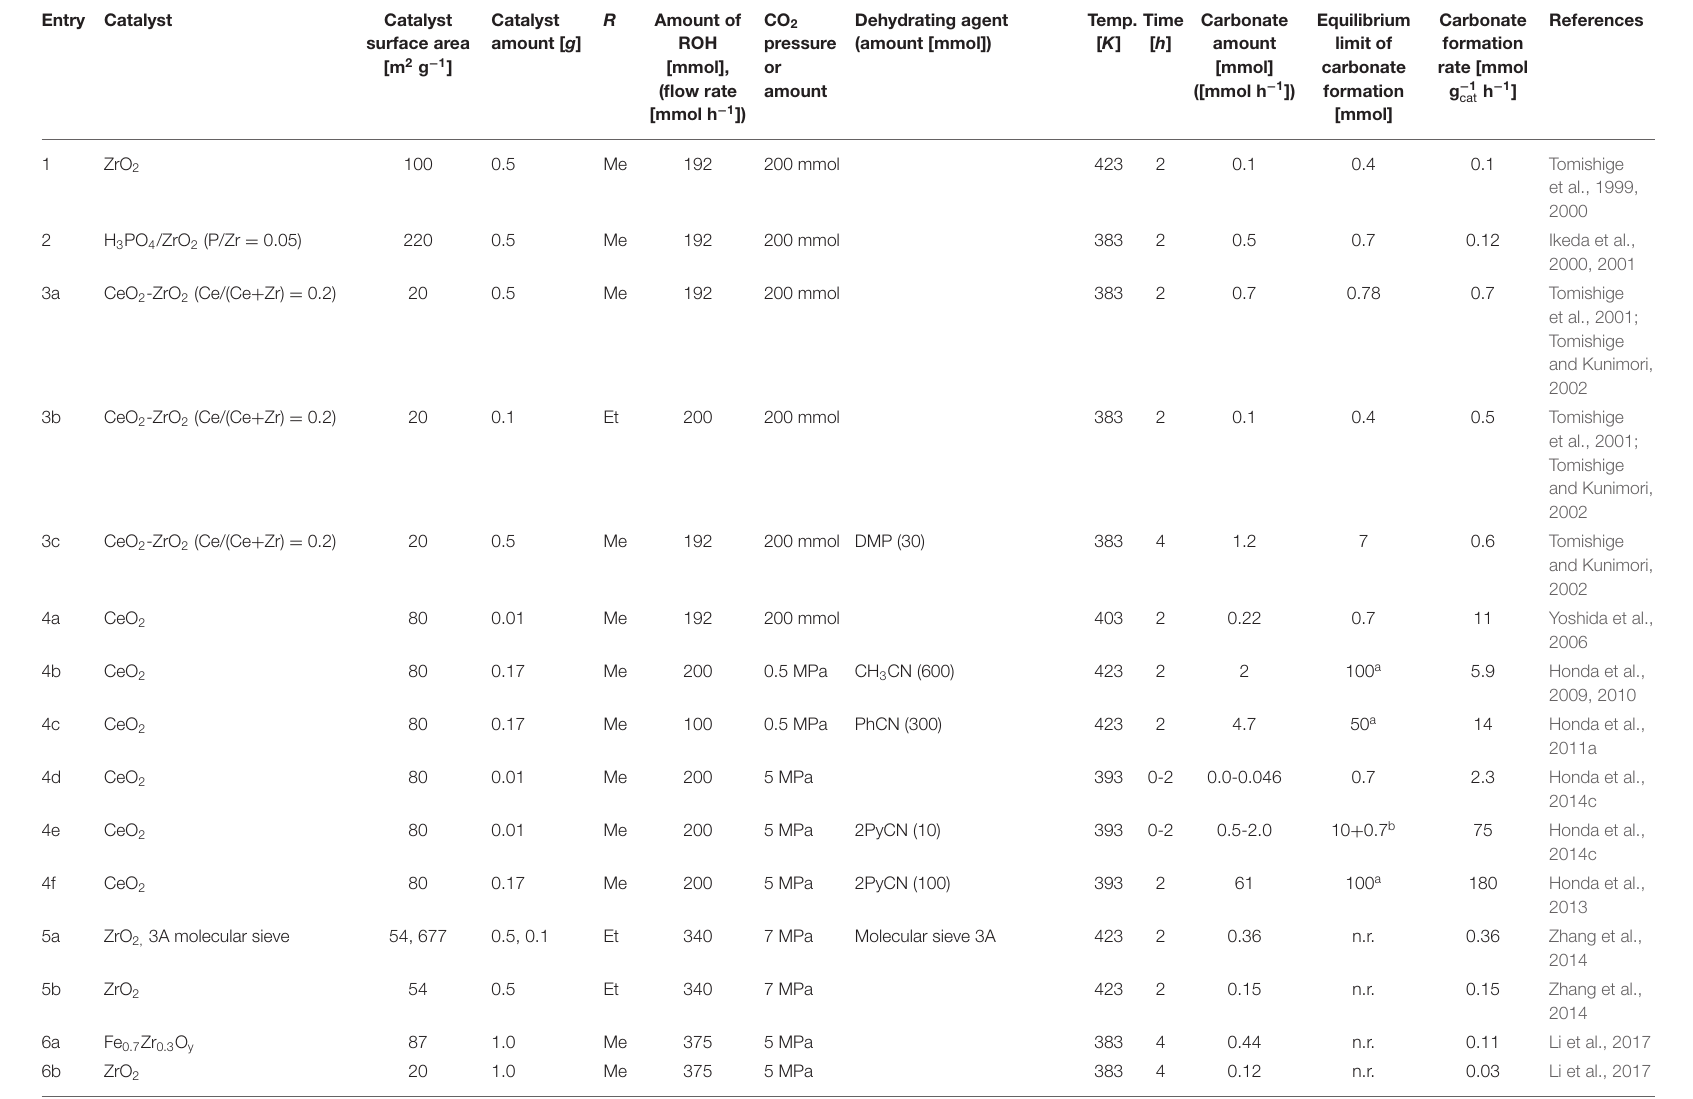
TABLE 2 | Summary of dialkyl carbonate synthesis systems from ROH and CO 2 using heterogeneous